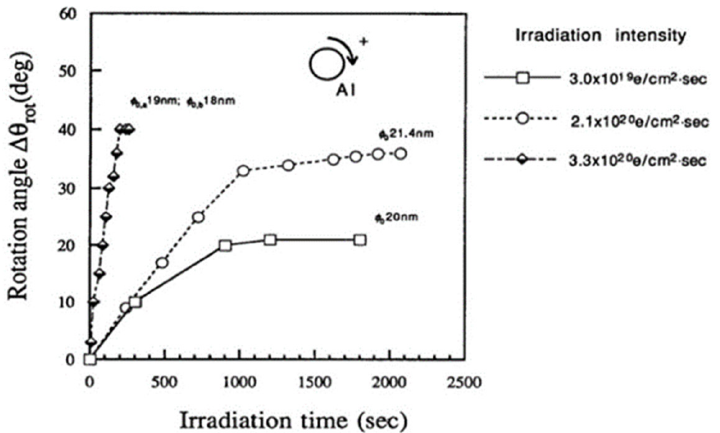
Figure 7. Rotation of Al nanodecahedra and its dependence on the irradiation intensity ranging from 3.0 × 10 19 to 3.3 × 10 20 e/cm 2 s. The diameter of the nanoparticles is 20 nm, denoted on the line as ϕ 0 [6].